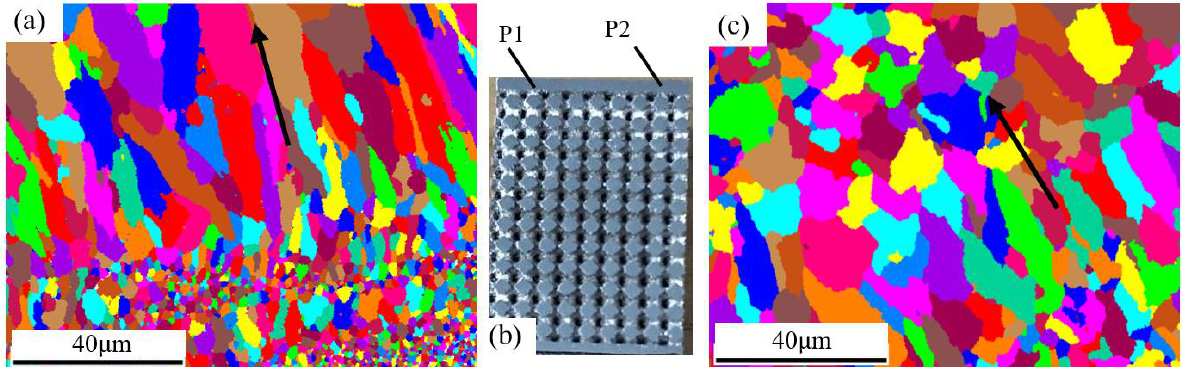
Figure 10. Grain structure on different spots: ( a ) spot P1; ( b ) P1 and P2 located in specimen; ( c ) spot P2.